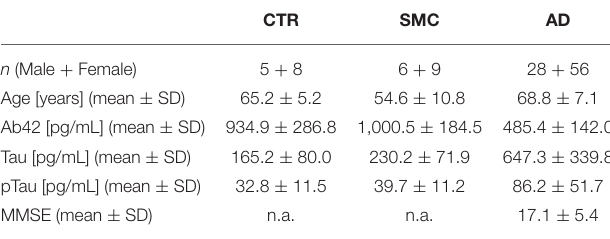
TABLE 1 | Sociodemographic and biomarker details of the study